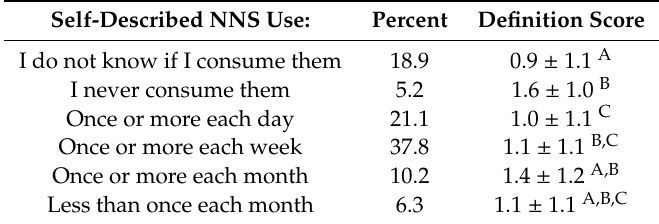
Table 1. Respondents who self-reported NNS avoidance provided NNS definitions with greater depth of